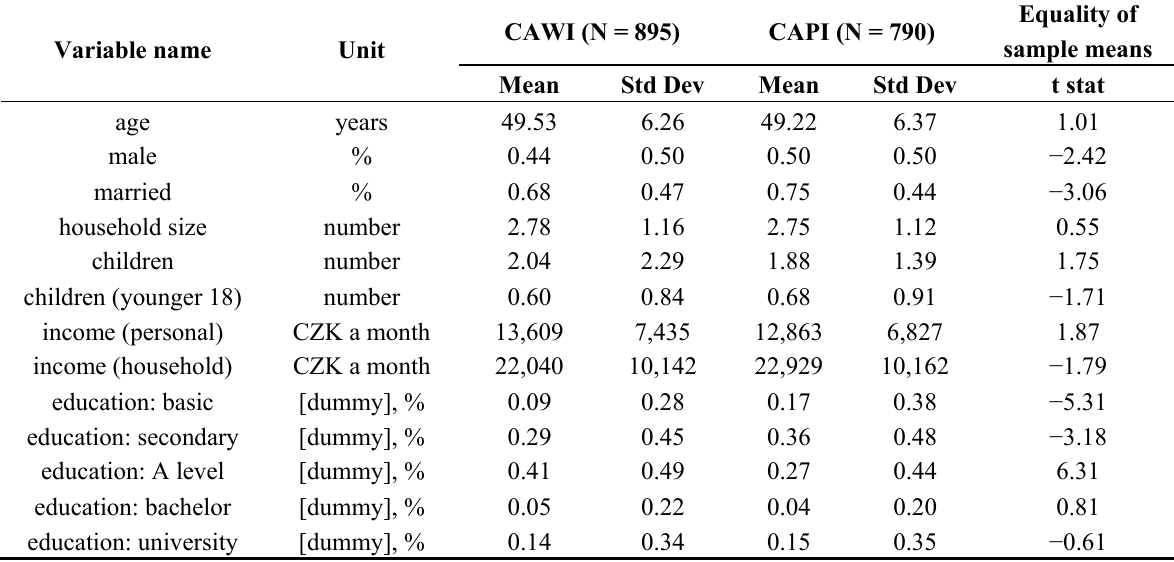
Table 3. Descriptive statistics of the CAWI and CAPI five-city